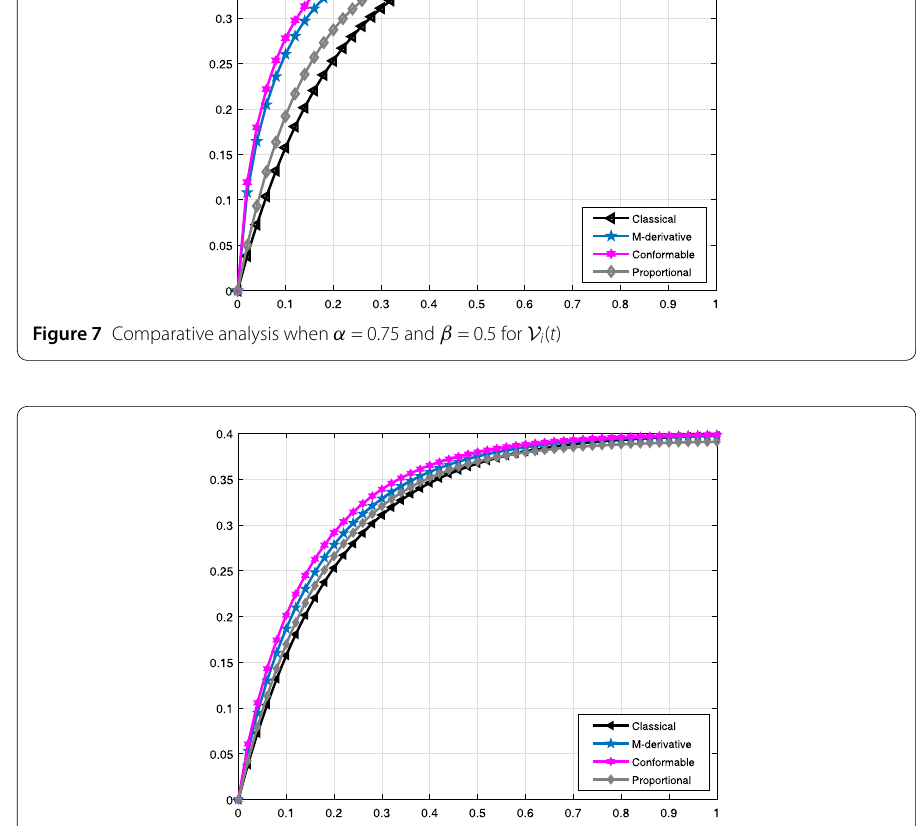
Figure 8 Comparative analysis when α = 0.9 and β = 0.8 for V i ( t